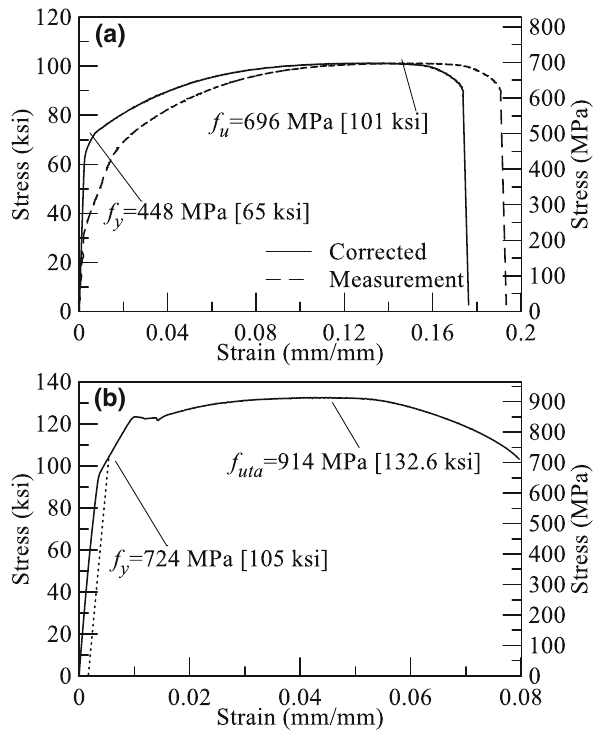
Fig. 5 Materials used in test: a No. 5 Grade 60 rebars and b ASTM A193 Grade B7 rods.